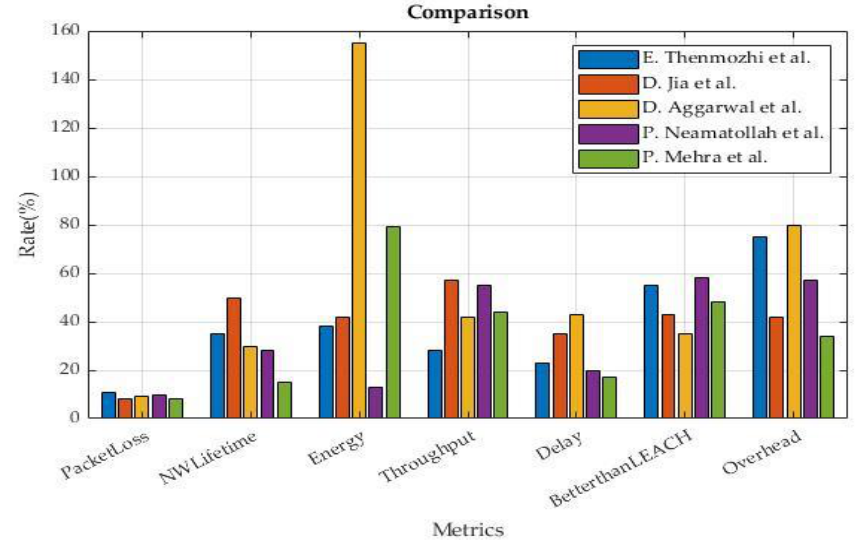
Figure 4. Comparison of the various methodologies and performance metrics.